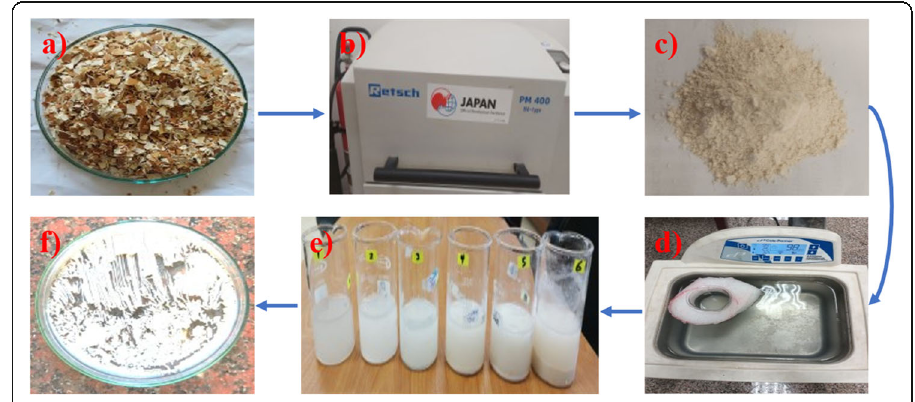
Fig. 1 Synthesis of biobased CaCO 3 nanoparticles from chicken